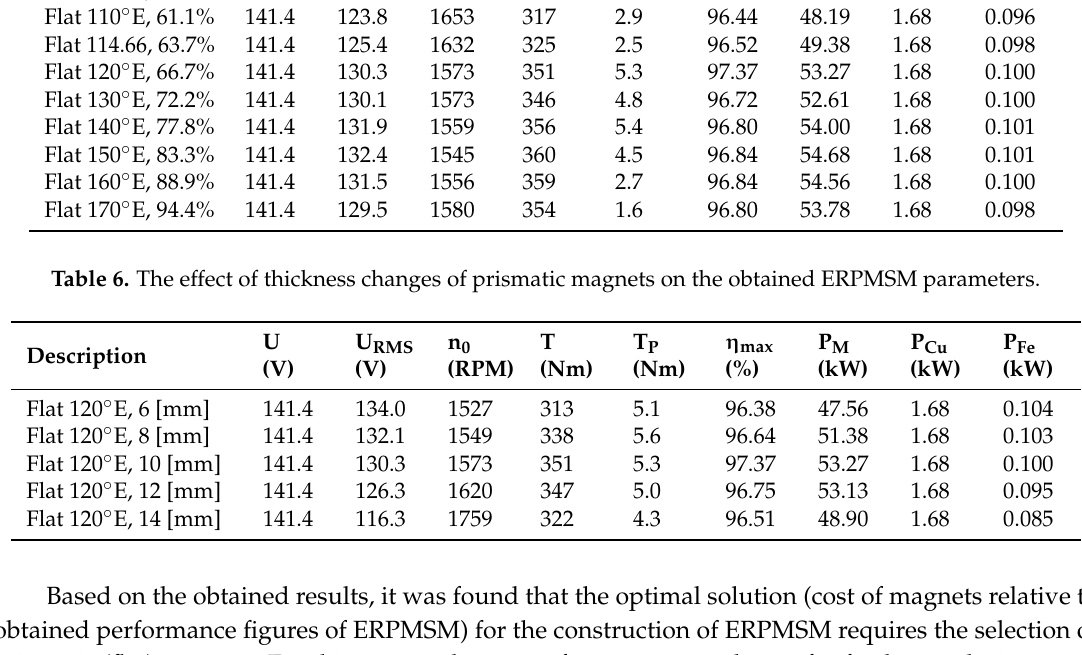
Table 5. The effect of changes in the length of prismatic magnets on the obtained ERPMSM parameters. Description